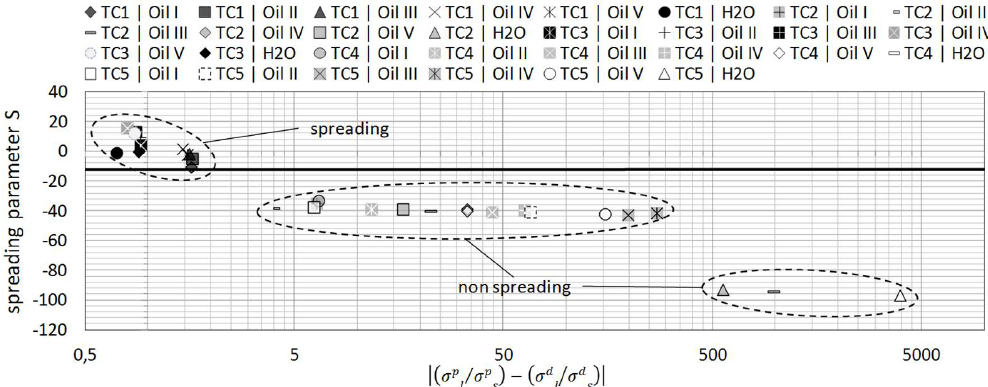
Figure 11. “ S ” depending on the absolute difference of the ratios of the dispersive and polar components. Considering the individual amount of the superimposed components of the surface energy, a good prediction of wetting behavior of a functional fluid on the respective treated textile can be